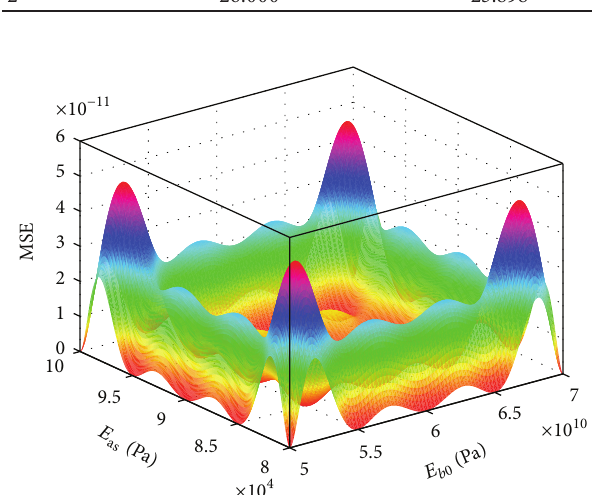
and 12. They demonstrate that all MSE values were close to accuracy.